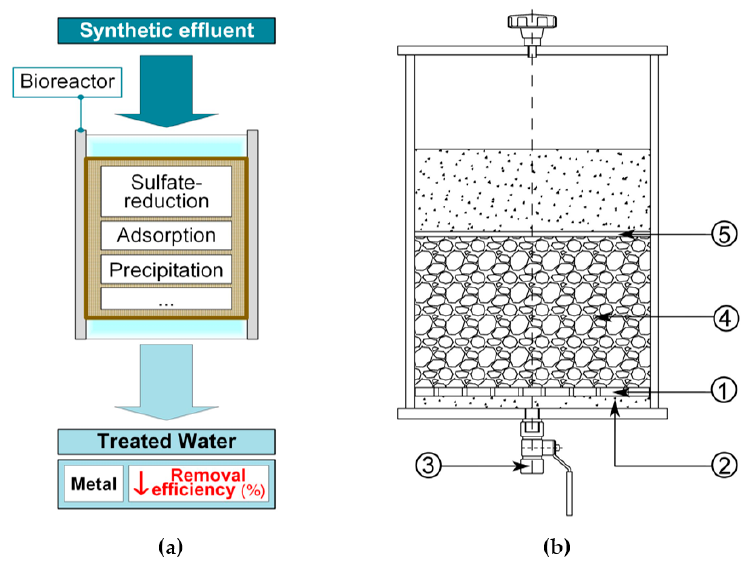
Figure 1. ( a ) Mechanisms for removal of heavy metals from synthetic effluent; ( b ) design of the bioreactors.